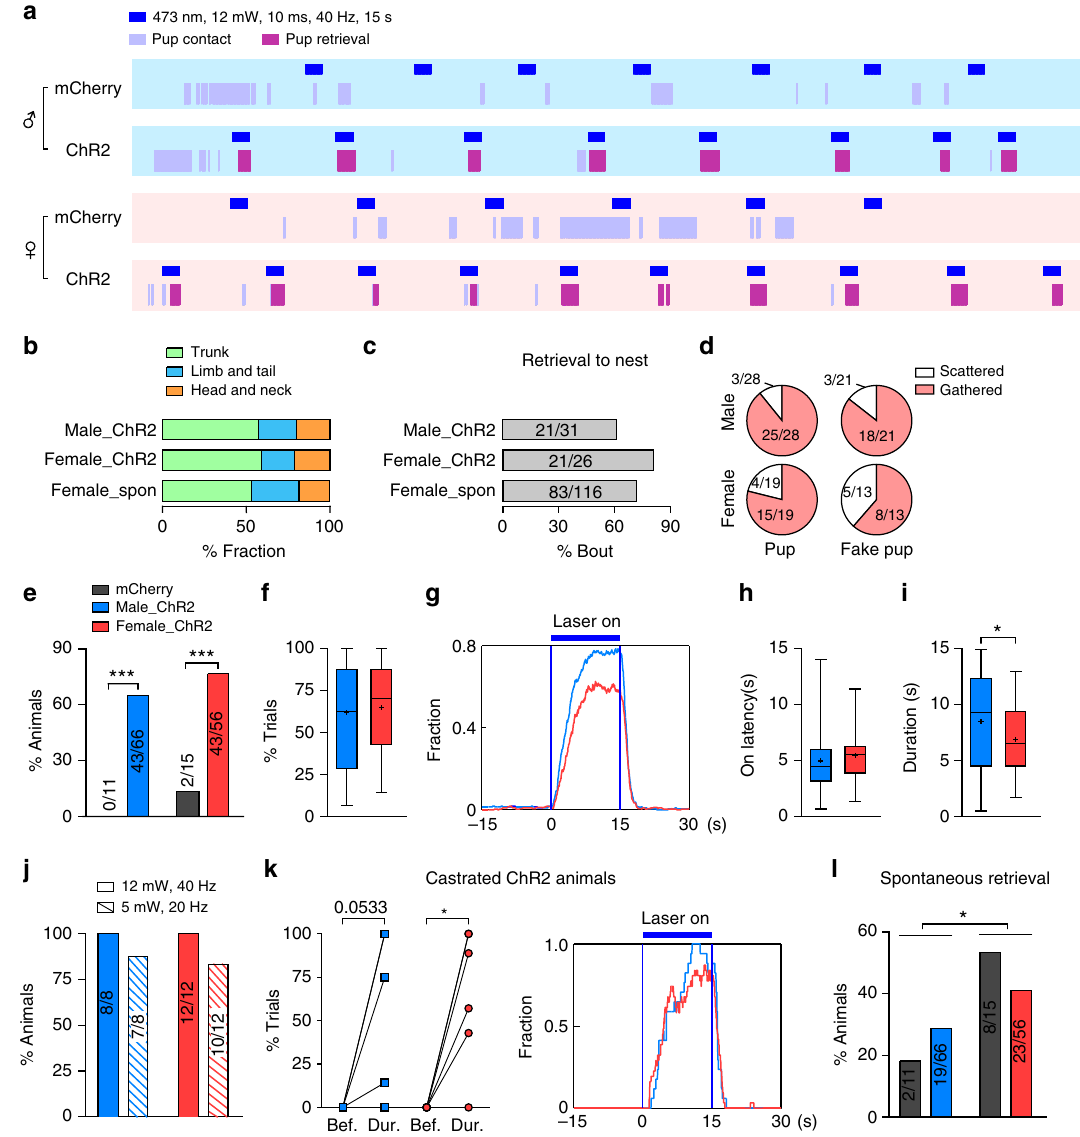
Bef. Dur. Fig. 3 Optogenetic activation of pup retrieval in both sexes. a Representative raster plots of behaviors (color coded) of mCherry and ChR2 animals of either sex during a behavioral trial in which scattered pups were given as the stimuli. Blue bars indicate periods of light stimulation. b Body regions of a pup contacted by ChR2 animals during optogenetically induced retrieval compared with spontaneous retrieval in virgin females (female_spon). N = 43 ChR2 males, 42 ChR2 females, and 10 virgin females. c Percentage of optogenetically induced retrieval bouts that resulted in a pup being brought to the nest in male and female ChR2 animals compared to spontaneous retrieval in virgin females (female_spon). N = 8 ChR2 males, 5 ChR2 females, and 10 virgin females. d Distribution of ChR2 animals of both sexes that grouped pups or fake pups. Only animals that did not display spontaneous pup retrieval were analyzed. Grouping was de fi ned by the appearance of ≥ 2 pups or fake pups together at the end of the behavioral trial. e – i Quanti fi cation of optogenetically induced pup retrieval behavior in both sexes. The percentage of animals that displayed pup retrieval behavior during photostimulation ( e ), trial-by-trial occurrence ( f ), average distribution ( g ), the latency ( h ), and average duration ( i ) of light-induced pup retrieval behaviors were plotted. N = 66 ChR2 and 11 mCherry for males, and 56 ChR2 and 15 mCherry for females. j Percentage of ChR2 animals showing light-induced retrieval behavior under low power and high power of stimulation. N = 8 males and 12 females. k Occurrence and distribution of pup retrieval before (bef.), during (dur.), and after light stimulation in ChR2 animals that had been castrated for > 3 weeks. N = 5 males and 6 females. l Spontaneous pup retrieval behavior outside of photostimulation period. N = 66 ChR2 and 11 mCherry for males, and 56 ChR2 and 15 mCherry for females. Fisher ’ s exact test in e and l . Unpaired t test in i . Paired t test in k . * p < 0.05, *** p <